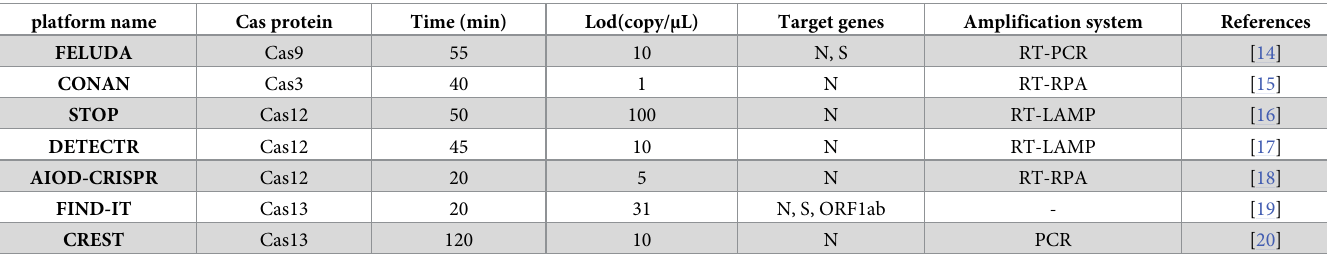
Table 1. CRISPR-based COVID-19 nucleic acid detection